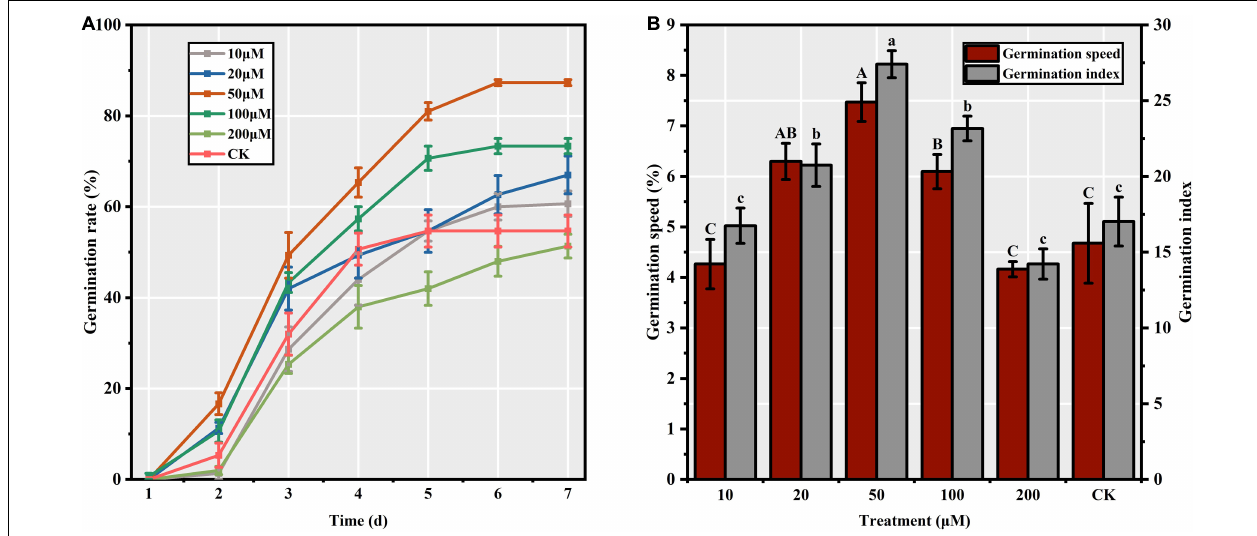
FIGURE 1 | Effect of melatonin priming on Suaeda corniculata seed germination (means ± standard errors, n = 3). (A) Germination rate of Suaeda corniculata seeds. (B) Germination speed and Germination index of Suaeda corniculata seeds. Different capital letters indicate the significant differences in GS at the 0.05 significance level. Different small letters indicate the significant differences in GI at the 0.05 significance